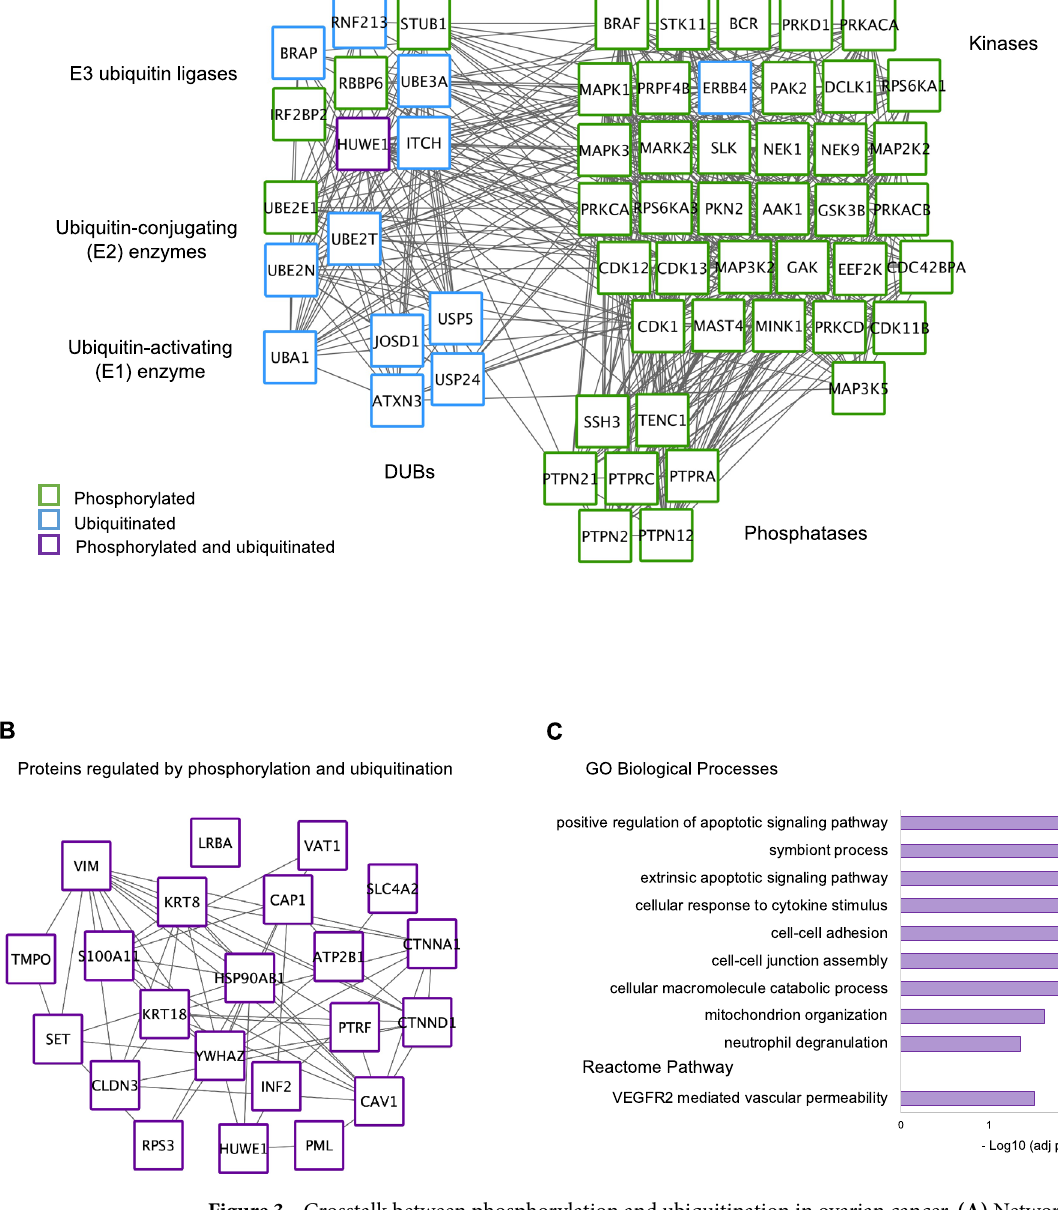
Figure 3. Crosstalk between phosphorylation and ubiquitination in ovarian cancer. (A) Network of kinases, phosphatases, ubiquitin-related (E1, E2, E3) and deubiquitinating enzymes (DUBs) modified by phosphorylation (nodes with green border), ubiquitination (blue border) or by both modifications (purple border) between high-grade serous cancer and benign tissues (q-value < 0.05). Edges represent protein–protein associations (B) Functional network of the 22 proteins (nodes) regulated by phosphorylation and ubiquitination (q-value < 0.05). Edges represent protein–protein associations (C) GOBP and Reactome pathway enrichment analysis of the 22 proteins represented in (B)